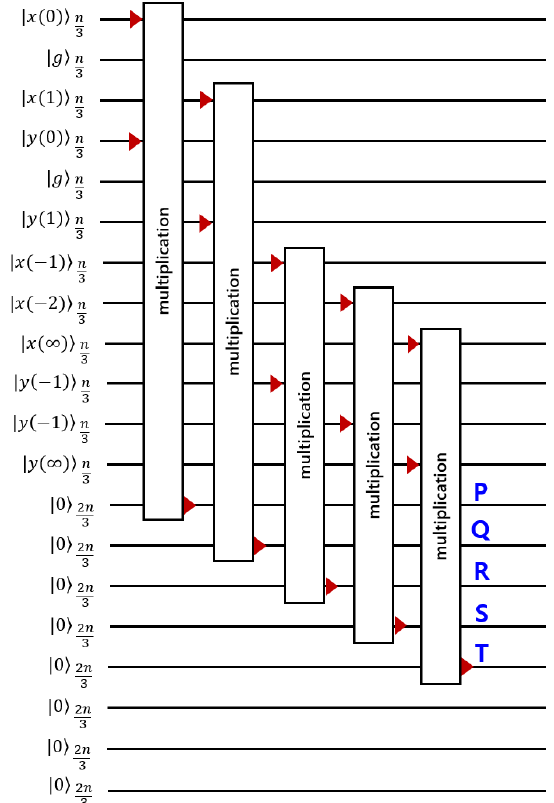
Figure 5. Quantum Circuit for Multiplication Part.